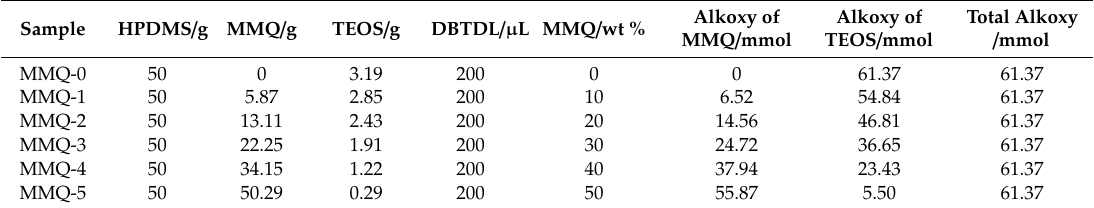
Table 1. The amounts of raw materials of room-temperature vulcanized (RTV) silicone rubber.